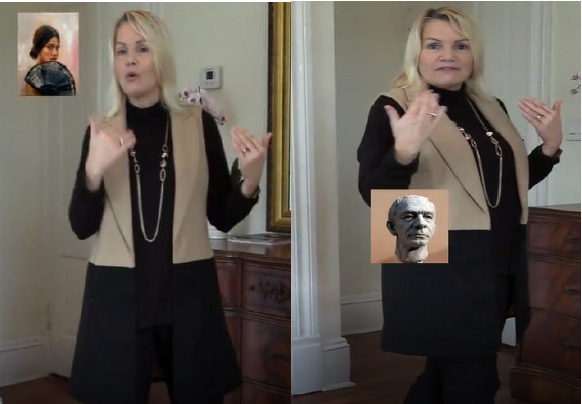
Figure 1. The example images are taken from a video with label is “REAL” of DFDC [19] dataset. Including real person along with many small pictures contain fake faces that are not the main person. Two images were captured at different time in the same video.